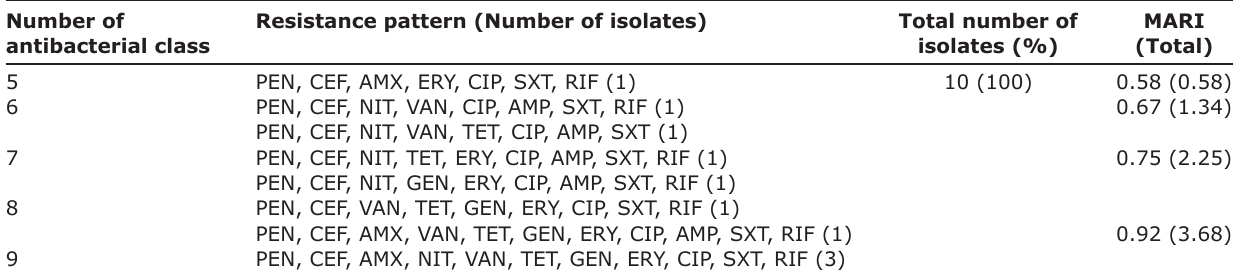
Table-5: Multiple antibacterial resistance patterns and indices of 10 Listeria isolates from raw pork marketed in Enugu State Southeast Nigeria. Number of Resistance pattern (Number of antibacterial class